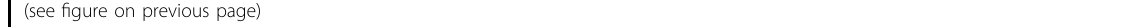
Fig. 1 Behavioral syndrome induced by ketamine in WT and GluN2CKO mice of both genders. Effects of ketamine (10 and 30 mg/kg) in male ( ♂ ) and female ( ♀ ) WT and GluN2CKO mice on: a total distance (percentage from saline-treated mice); b peripheral distance (percentage from saline- treated mice); c central distance (percentage from saline-treated mice); d rearings (percentage from saline-treated mice); e hindlimb abduction; f falls and g circling. Male WT saline ( n = 15); male GluN2CKO saline ( n = 16); female WT saline ( n = 18); female GluN2CKO saline ( n = 17); male and female WT and GluN2CKO ketamine 10 mg/kg and male GluN2CKO ketamine 30 mg/kg ( n = 8); male WT ketamine 30 mg/kg ( n = 10); female WT